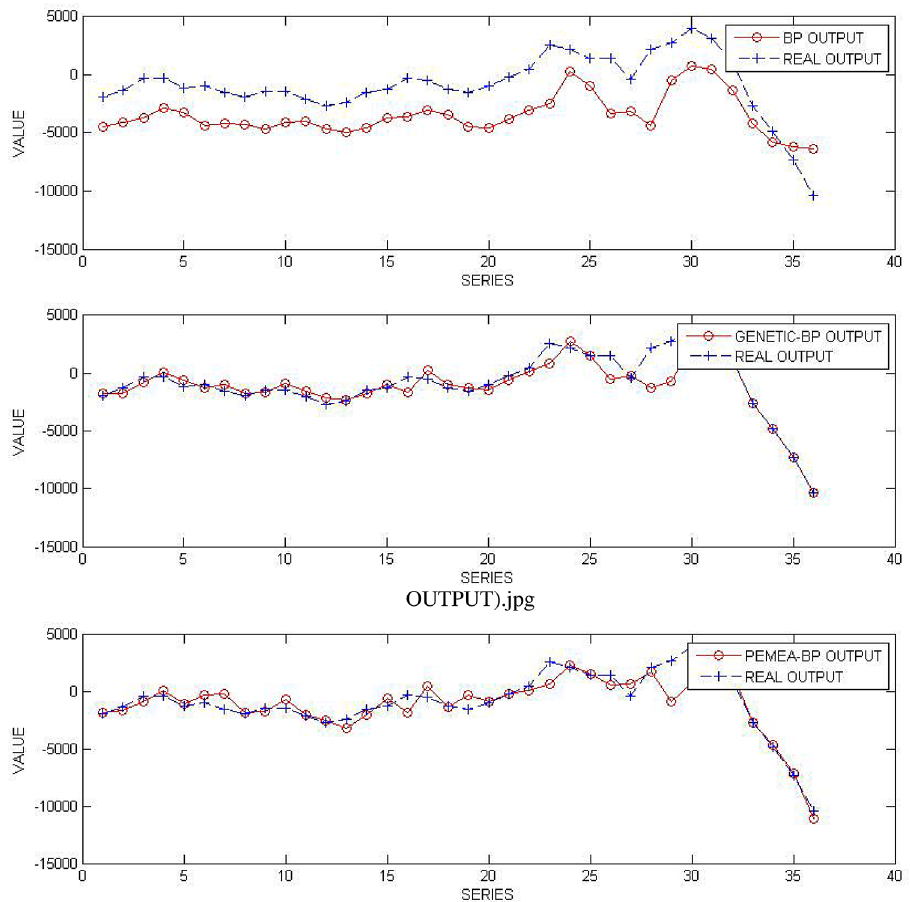
Figure 4. Comparison of actual data and network output.